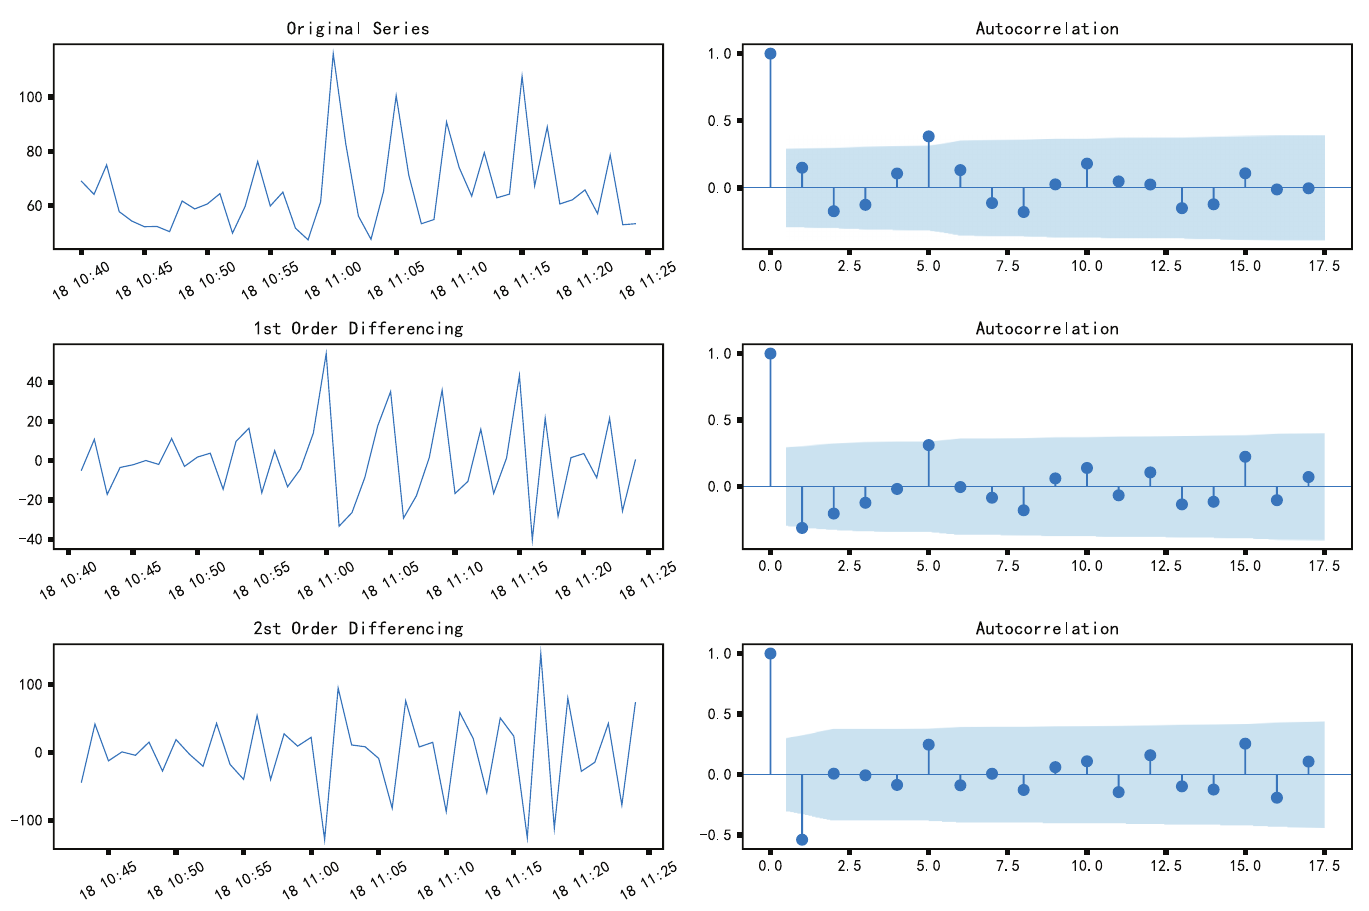
Fig 17. Autocorrelation diagram of differential sequence.